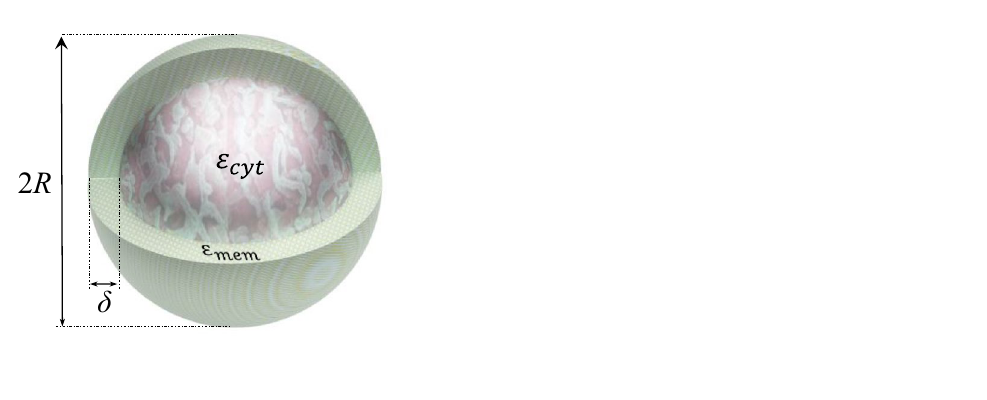
Figure 3. Single shell model of a